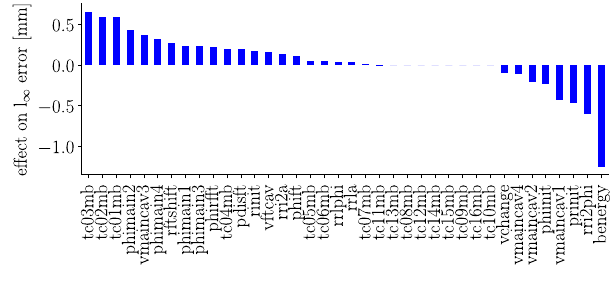
FIG. 19. Total effect during the local search on the l ∞ error per design